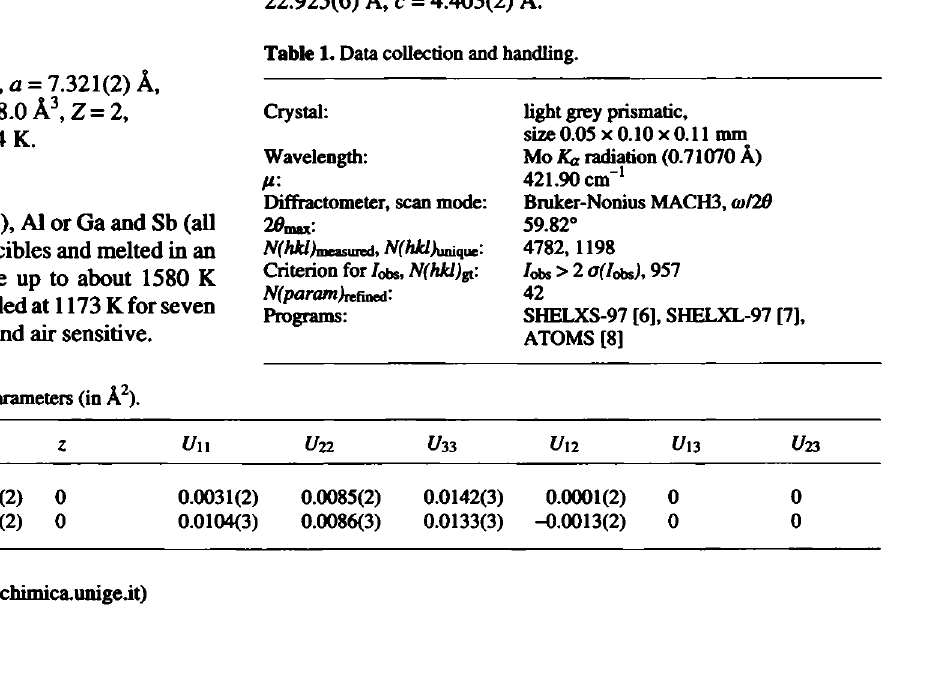
Table 1. Data collection and handling.